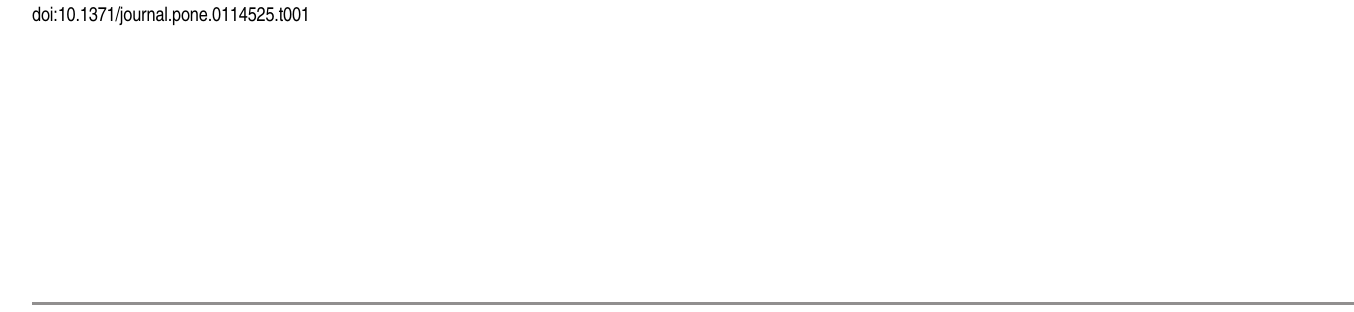
None GO-ID indicates the identifier associated with the gene ontology term as defined by the Gene Ontology project (www.geneontology.org). Underlined adjusted P -value indicates under-represented gene ontology